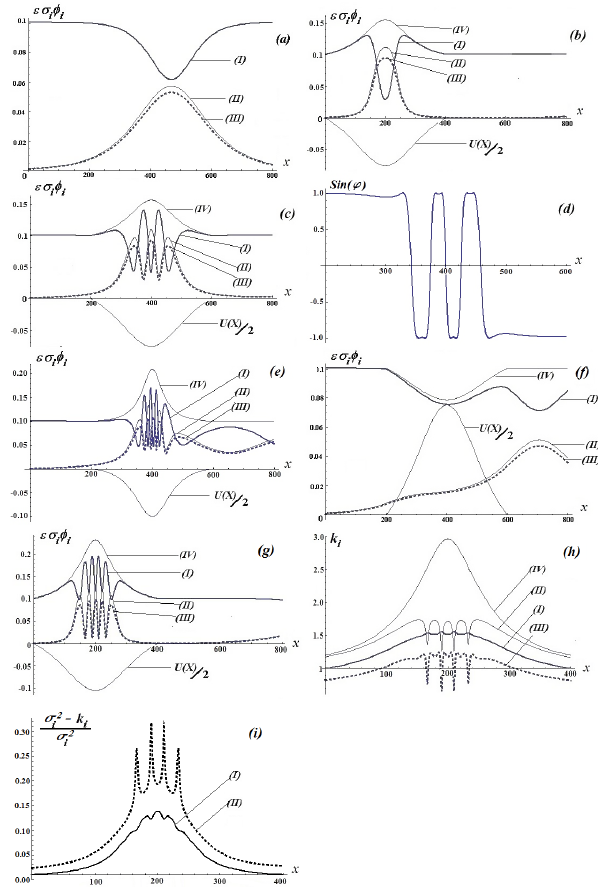
Figure 1. (a) BF instability without current. (b) and (c) modula- h i ε 2 (x − x 0 ) tion of surface waves by adverse current U = U 0 Sech , ( U 0 = − 0 . 15 ) ; (b) x 0 = 200 and (c) x 0 = 400. (d) phase differ- ence function ϕ [ X ] = 2 θ 1 [ X ]− θ 0 [ X ]− θ 2 [ X ] , θ 1 [ 0 ] = 0 ; θ 0 [ 0 ] = θ 2 [ 0 ] = − π/ 4; (e) modulation of surface waves by adverse cur- h i rent U = U 0 Sech 2 ε 2 (x − x 0 ) , ( U 0 = − 0 . 2 ) , (f) modulation in- stability for following current ( U 0 = 0 . 16, x 0 = 400 ) . (g) and (h) functions of wave amplitude and wave number, respectively, for U 0 = − 0 . 2. (I), (II), (III) amplitude envelopes of the carrier, super- harmonic and subharmonic waves, respectively. (IV) linear solution for the carrier envelope. The initial steepness of the carrier wave is ε = 0 . 1, side band initial amplitudes are equal to 0 . 1 ε . (i) Rela- tive distortion of the linear dispersion relation for the case (g) , (I) – carrier, (II) – higher side